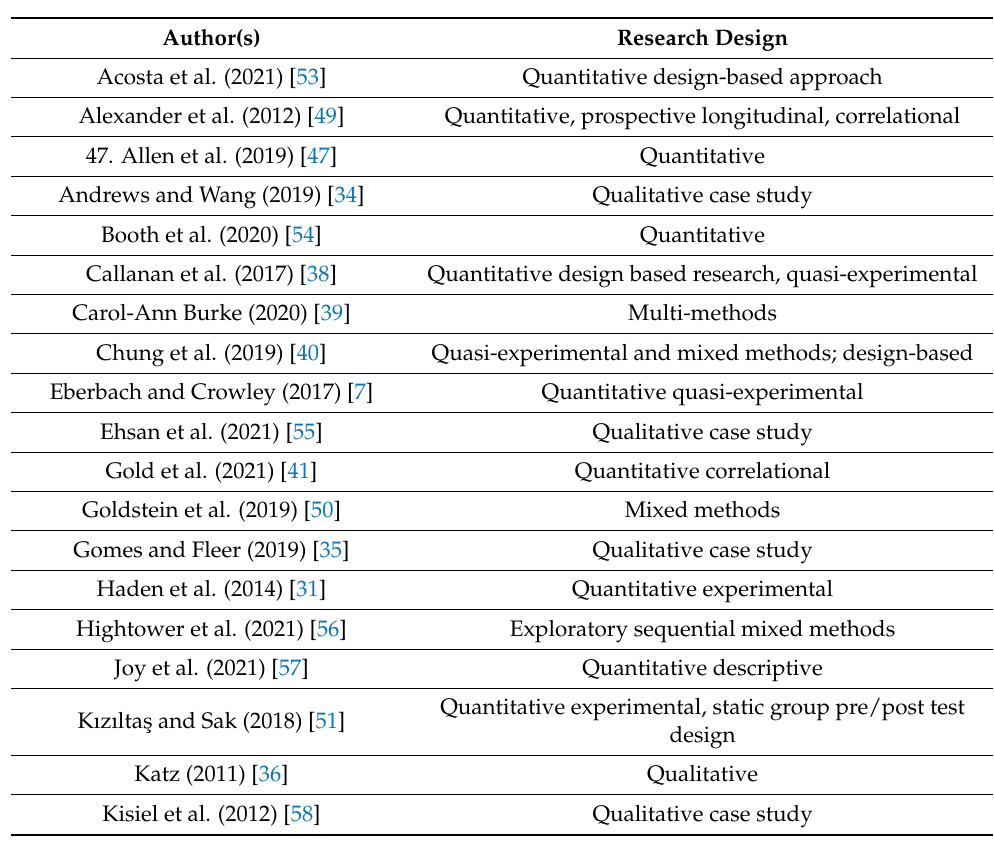
Table 2. Summary of research